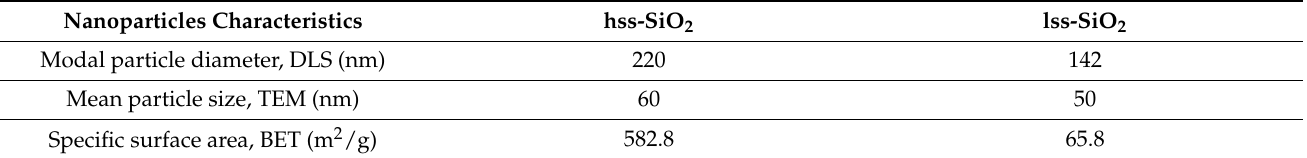
Table 2. Characteristics of the silica nanoparticles used in